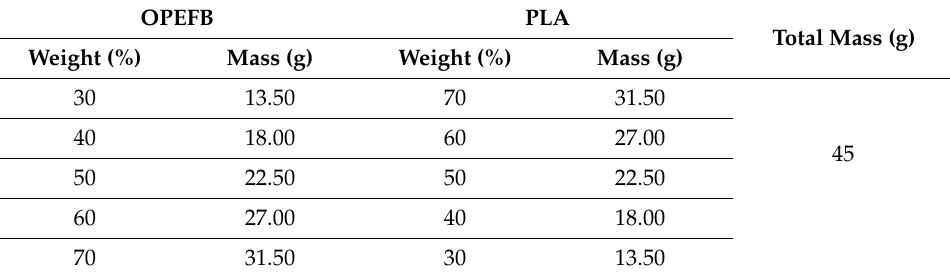
Table 1. OPEFB / PLA composites at di ff erent percentages of